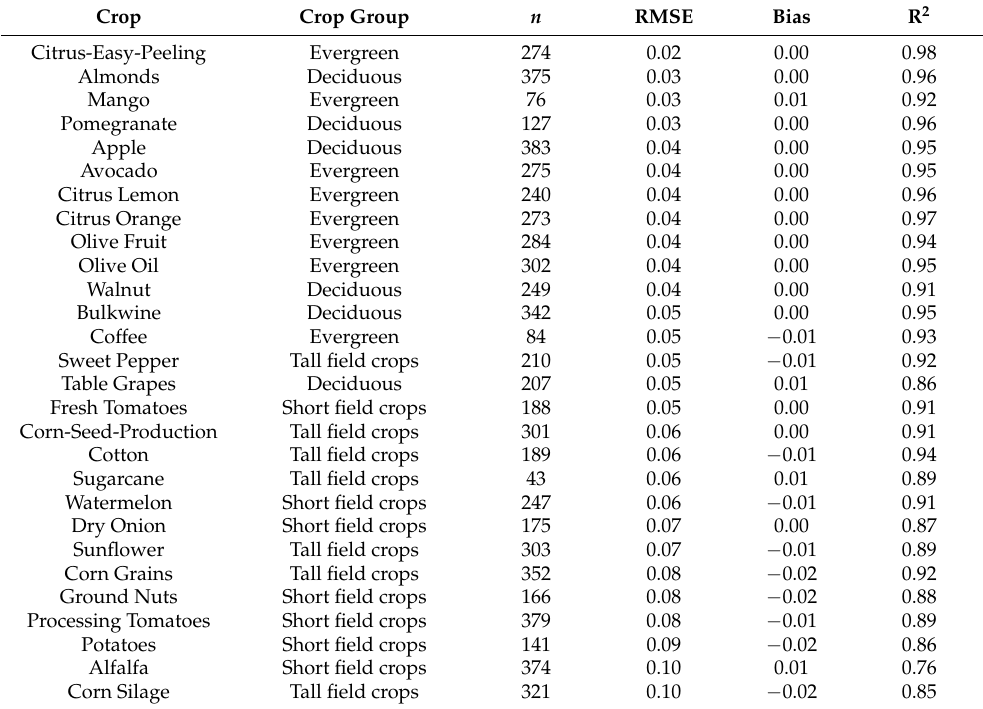
Table 5. SNAF performance per crop (sorted by